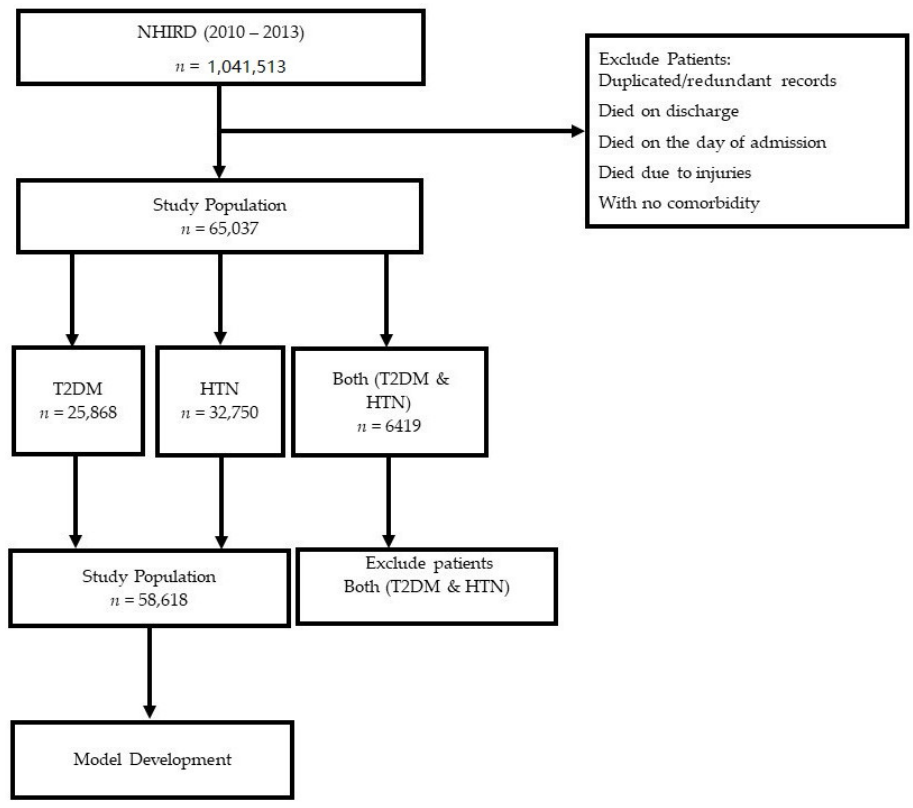
Figure 1. Flowchart illustrating patient selection process .